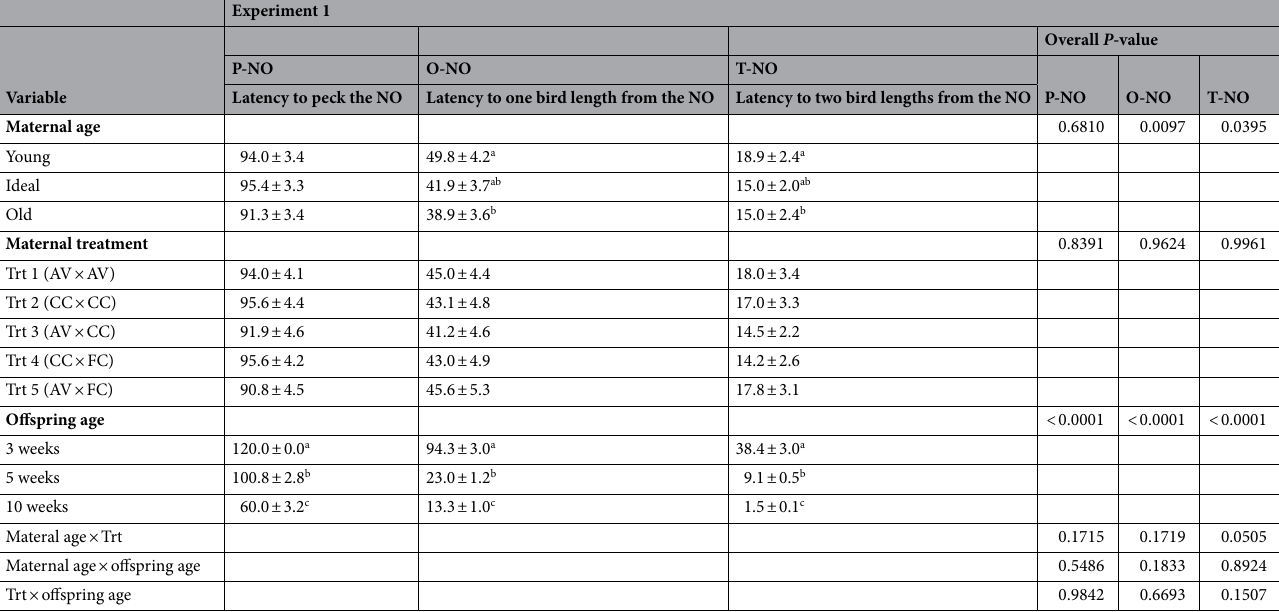
Table 3. Novel object test. Means ± SEM for latency to peck and latency to approach a novel object for progeny from Experiment 1. abc Values within a column for Maternal Age and Progeny Age with different superscripts differ P <